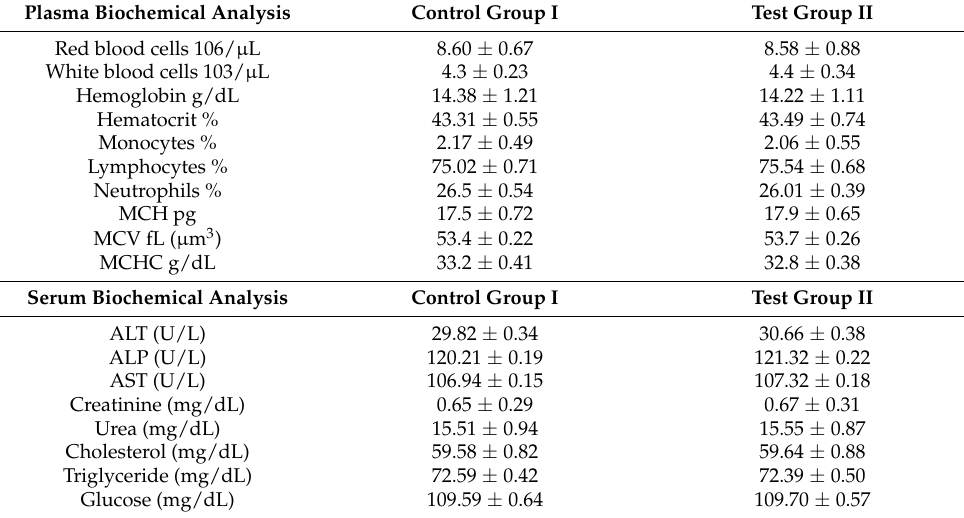
Table 4. Biochemical blood analysis in the control and test group of